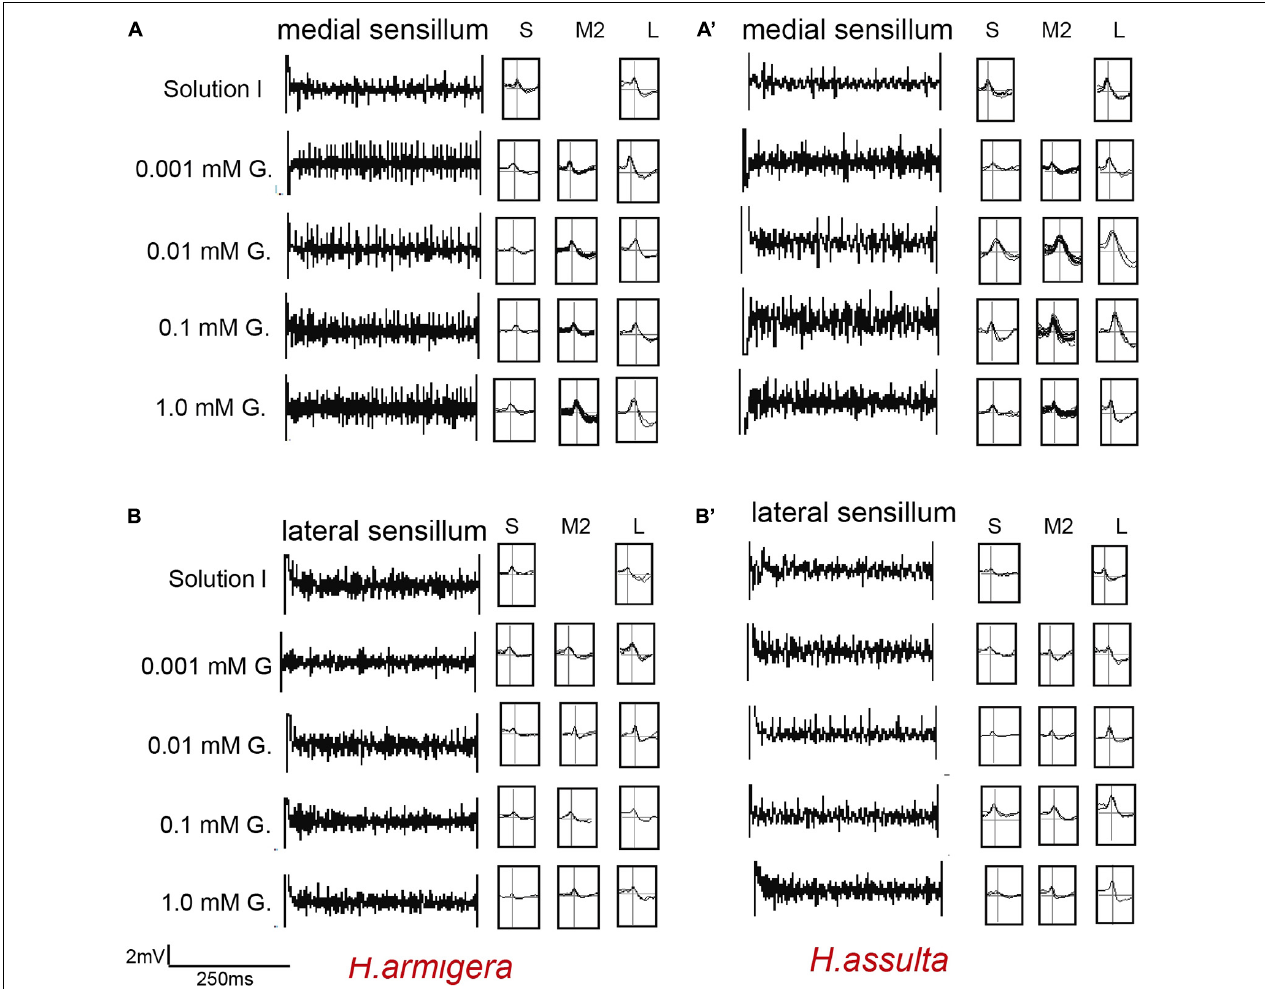
FIGURE 5 | Representative traces and indentified GRNs from the responses of the styloconic sensilla of Helicoverpa caterpillars to gossypol. “S,” “M2,” and “L” GRNs in H. armigera (A,B) and H. assulta (A’,B’) represent the identified GRNs from recording traces based on the analysis of AutoSpike software. G: gossypol. The time duration of each trace is 500